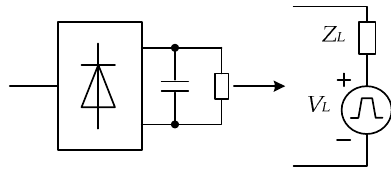
Figure 2. Equivalent harmonic voltage source.